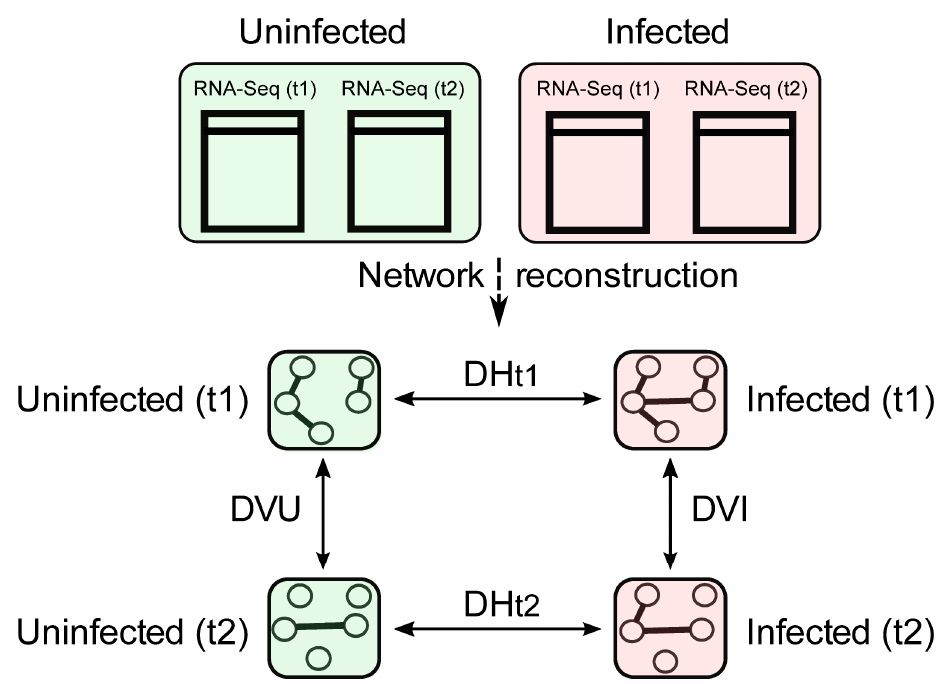
Figure 1. Schematic overview of the proposed approach. First, the RNA sequencing (RNA-Seq) expression networks are used to reconstruct four different regulatory networks, each corresponding to a particular phenotype uninfected with ‘ Ca . P. solani’ (U) or infected with ‘ Ca . P. solani’ (I), or the time of sequencing (t1, t2). The proposed methodology enables the exploration of eight main directions, depending on the time and phenotype considered (vertical lines, V), and also an exploration of differences between phenotypes within the same time frame (horizontal lines, H). D, dissipation, e.g., DVU, dissipation-vertical-uninfected; DVI,